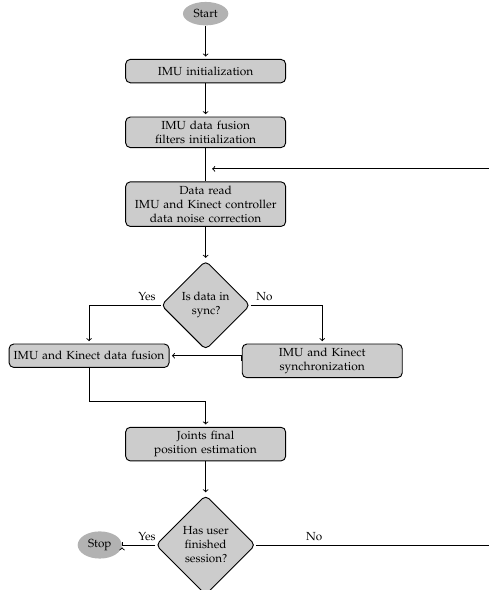
Figure 8. Orientation based data fusion method